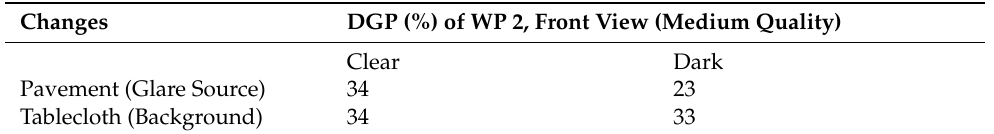
Table 3. background surface.